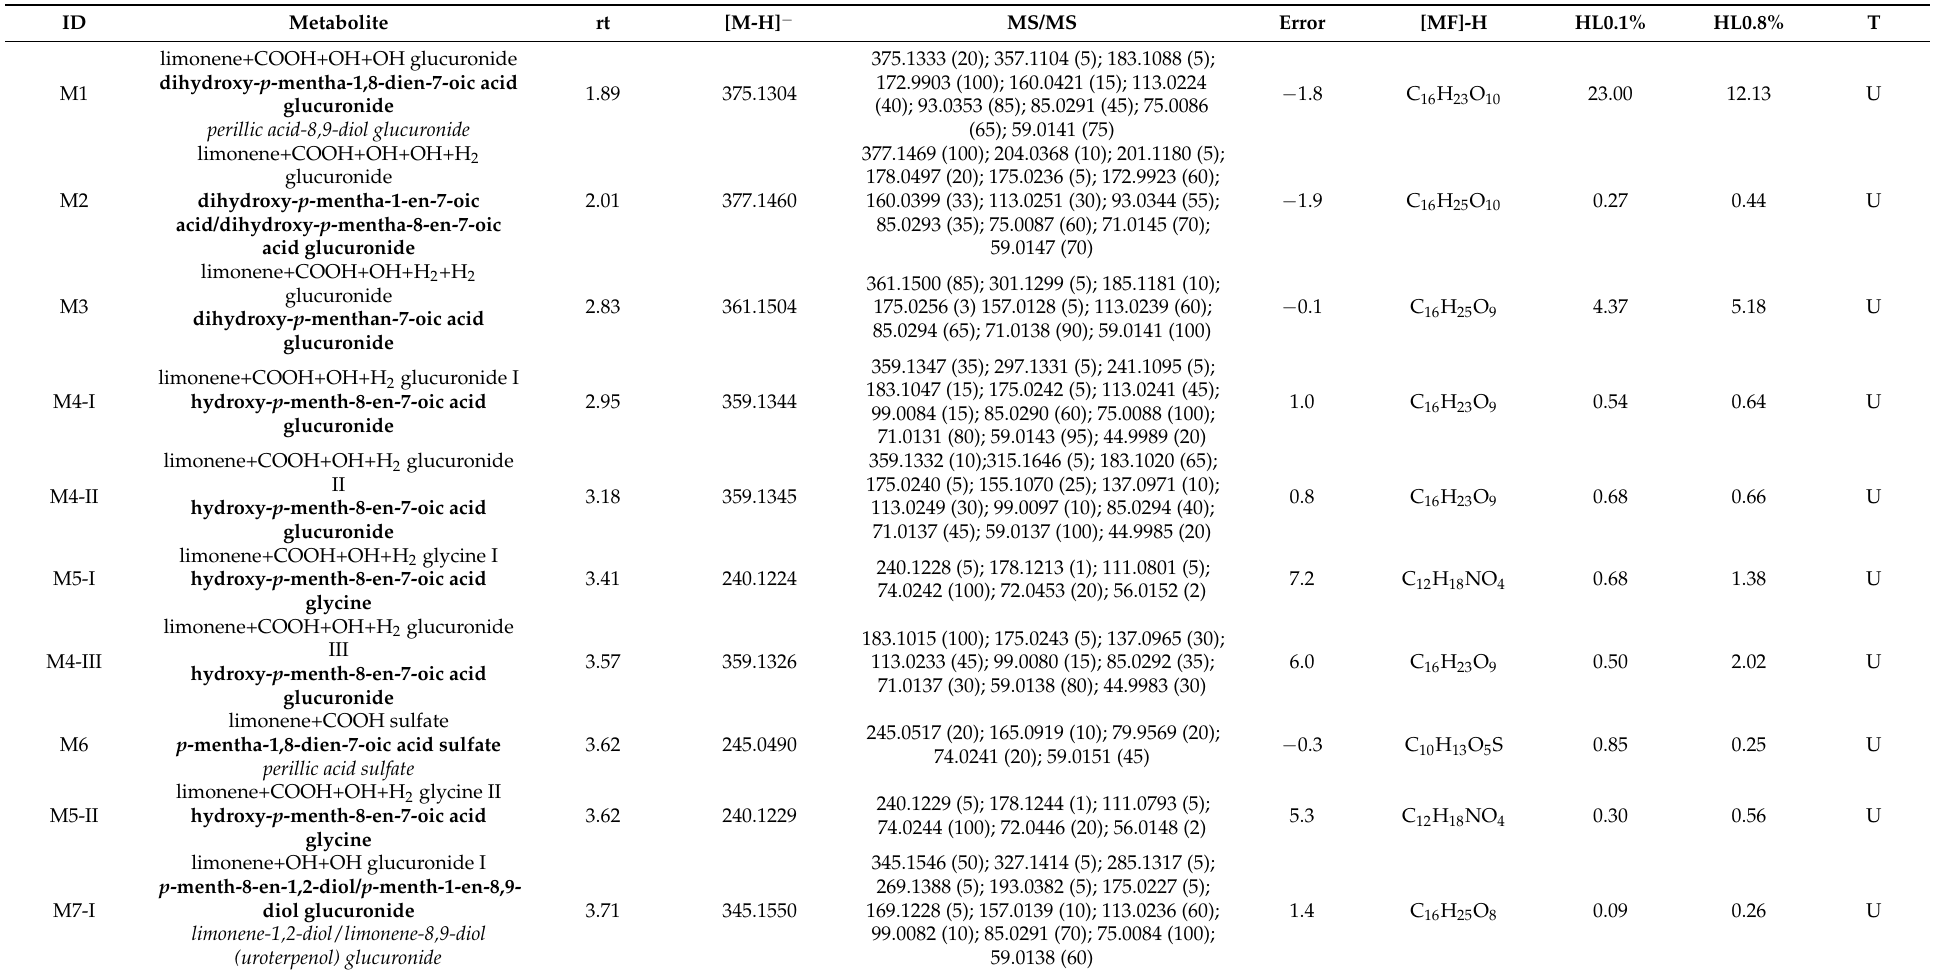
Table 2. Identification of D-limonene metabolites in urine and liver samples after a six-week